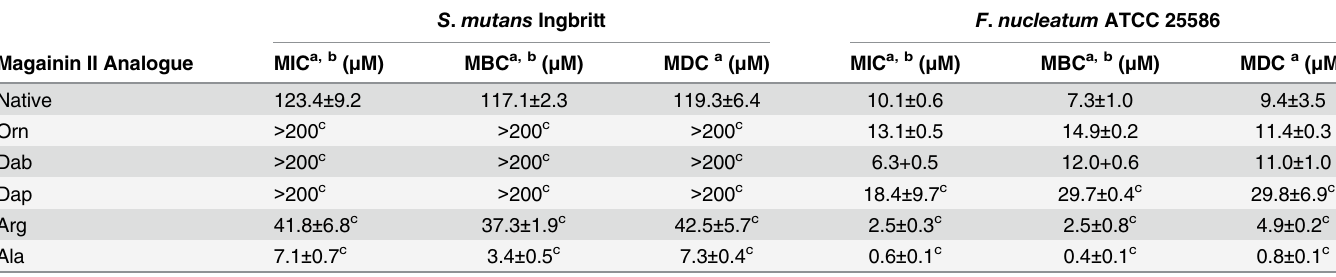
Table 3. Antimicrobial activity of Magainin analogues against S . mutans , and F . nucleatum . S . mutans Ingbritt F . nucleatum ATCC 25586 Magainin II